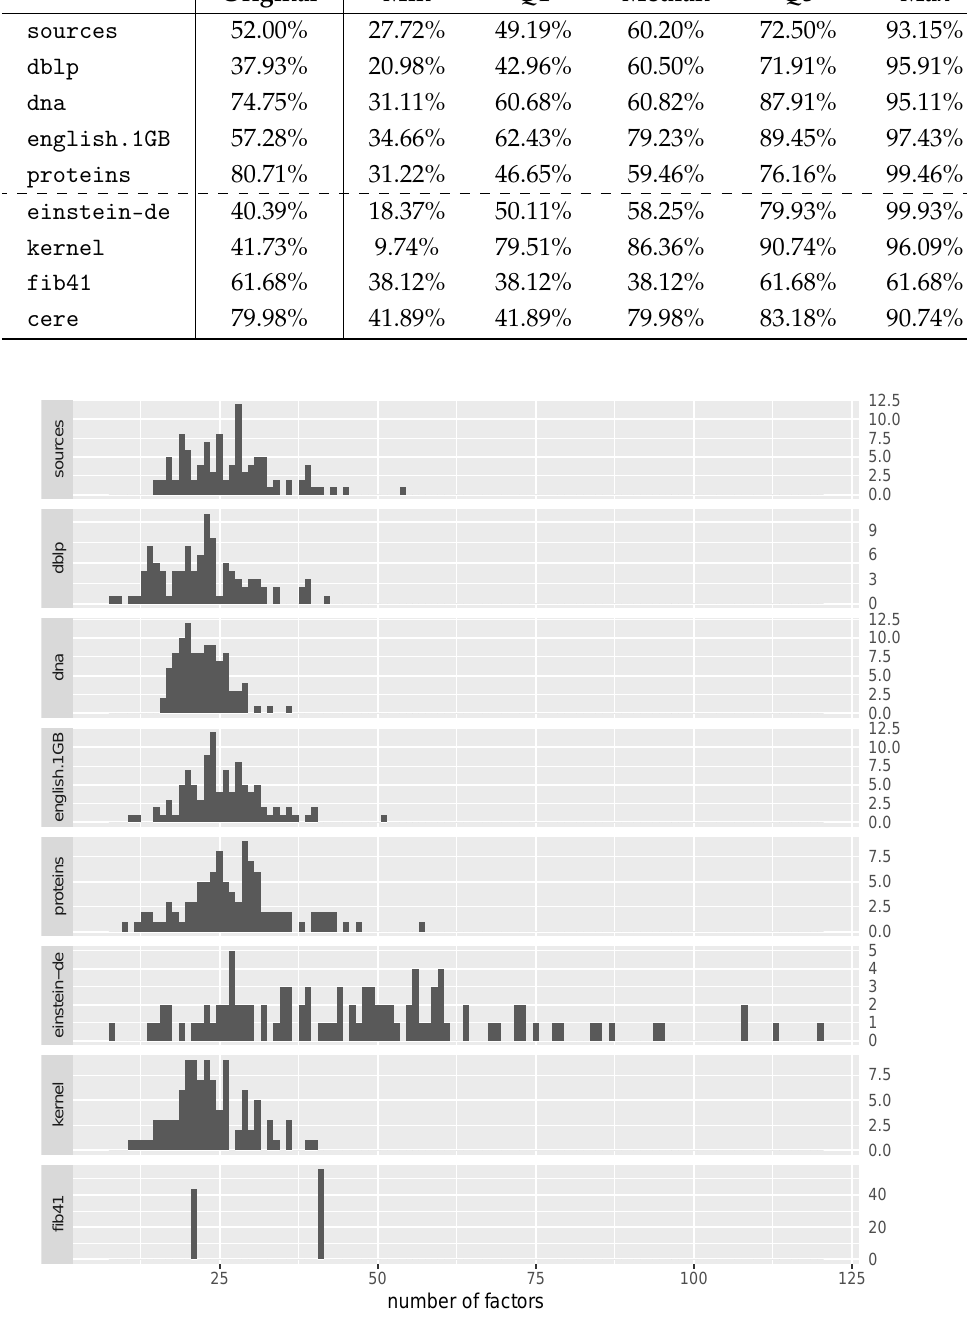
Figure 3. Number of factors for random permutations of the alphabet. Shapiro–Wilk normality tests, with p = 0.05, discarded normality of all distributions, except for kernel